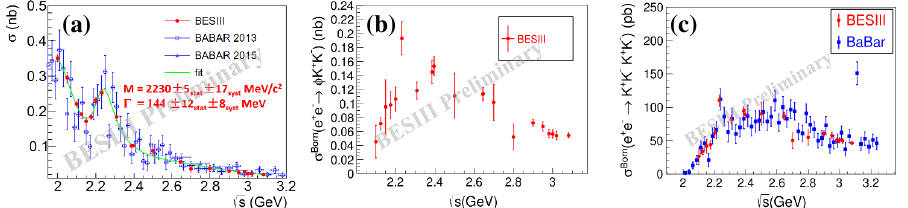
Figure 2. Cross section of e + e − → K + K − (a), e + e − → φ K + K − (b) and e + e − → φ K + K − K + K −